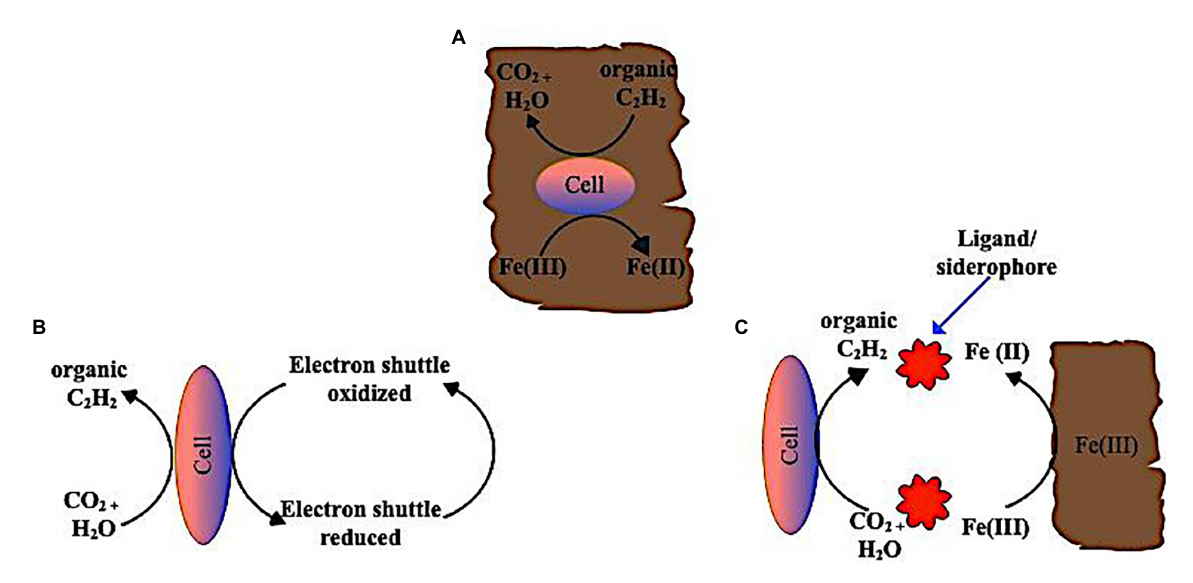
FIGURE 4 Mechanism of dissimilatory reduction of insoluble Fe (III) oxides in soil via (A) direct contact of bacteria cells to oxide surface of Fe(III) (B) extracellular electron shuttle mediating transfer of solid phase Fe(III) oxides and bacteria cells (C) Ligands (chelators/siderophores) helps solubilize solid phase Fe(III) and make Fe(III) in soluble form readily available to the bacteria